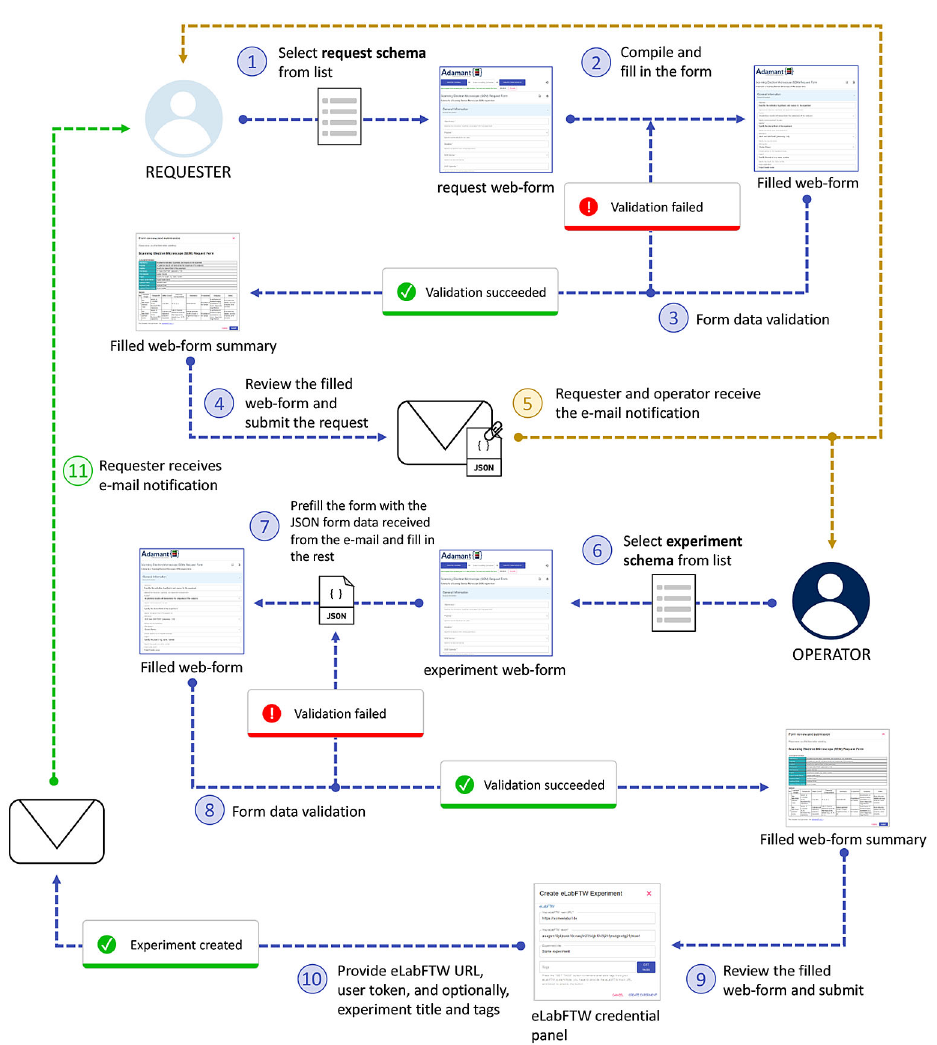
Figure 6. Job request workflow using Adamant involving two users: a requester and an operator. JSON, JavaScript Object